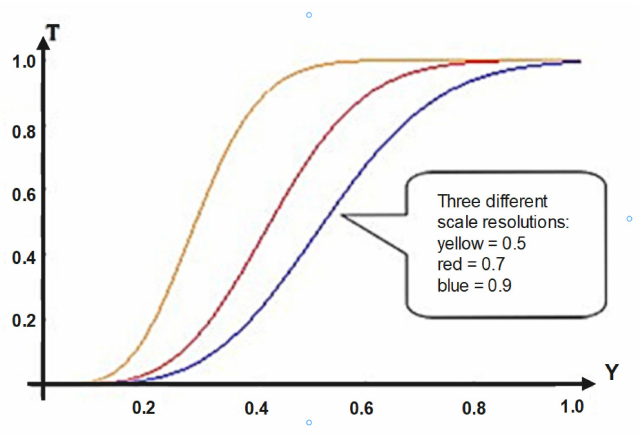
Figure 6. Detail of the variation in the transparency coefficient at three different scale resolutions, for a variation in Y in the interval 0 ÷